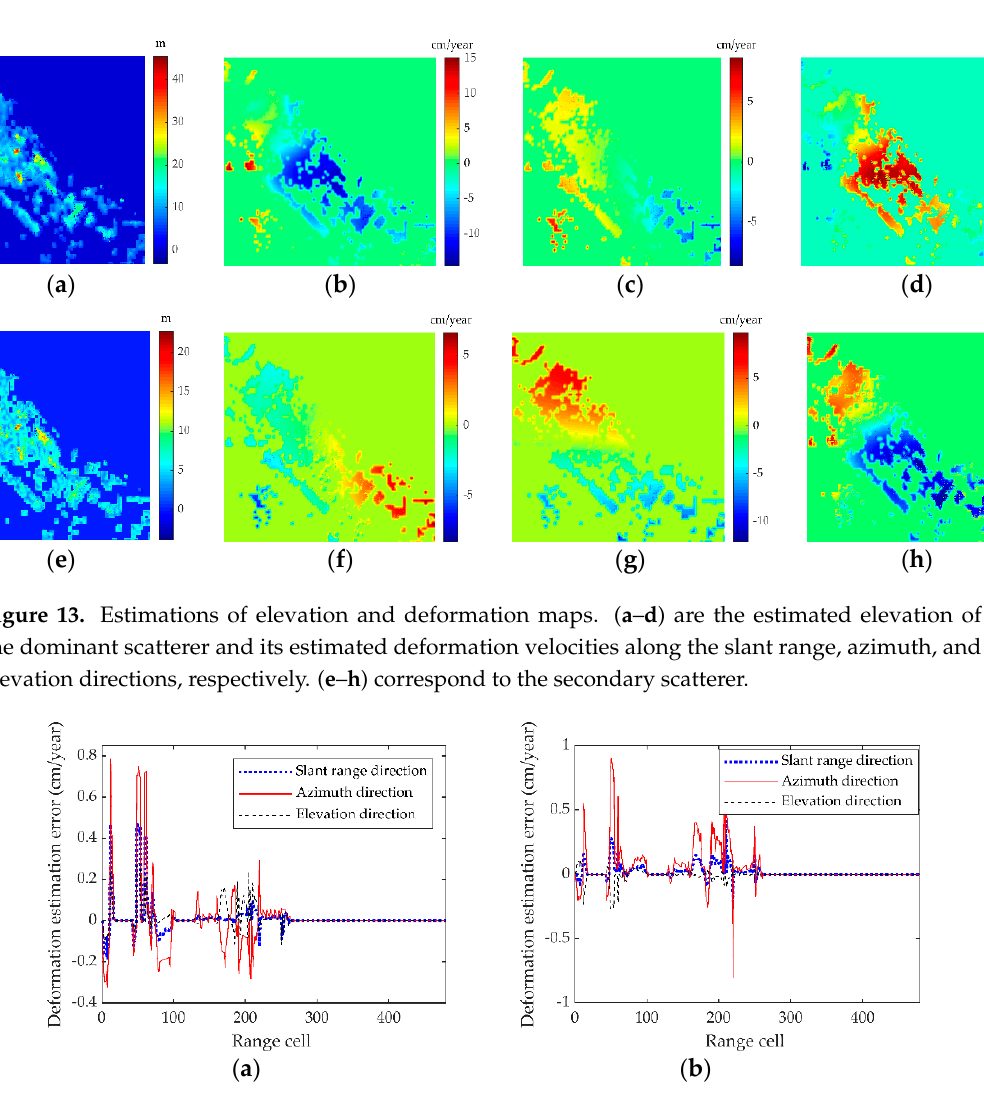
Figure 12. The simulation of elevation and deformation maps. ( a )–( d ) are the simulated elevation of the dominant scatterer and its simulated deformation velocities along the slant range, azimuth, and elevation directions, respectively. ( e )–( h ) correspond to the secondary scatterer.